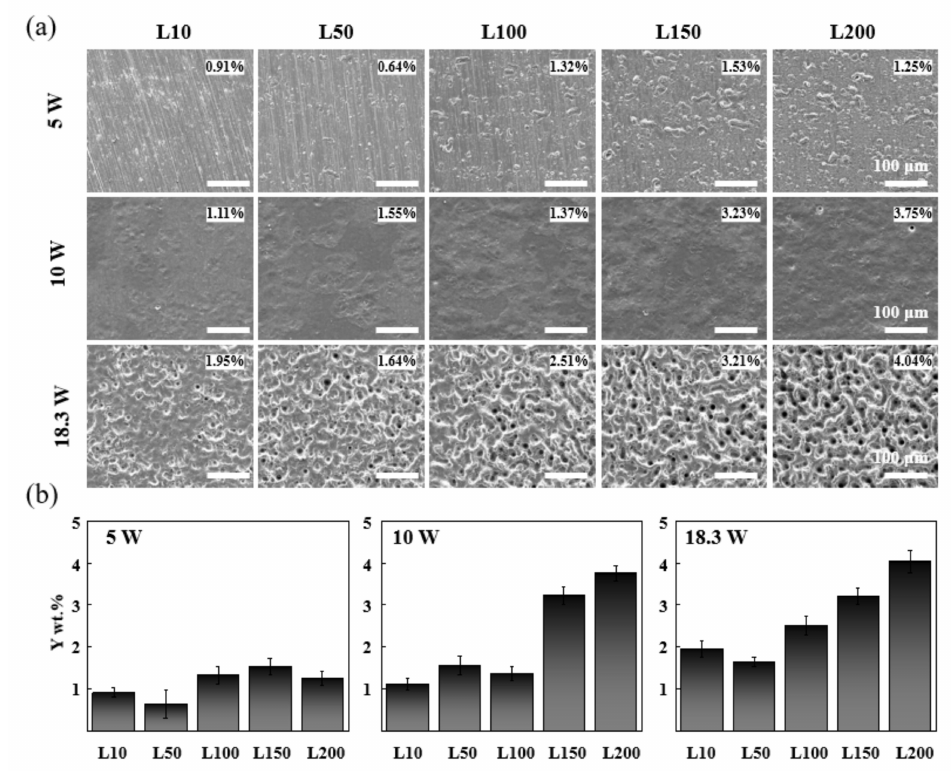
Figure 2. ( a ) SEM images of laser-treated Al showing surface morphology, and ( b ) weight percentage of coated Y on the Al substrate depending on laser parameters (power, loop) in the Y(NO 3 ) 3 precursor solution. In the SEM images, the numerical values indicate the weight percentage of